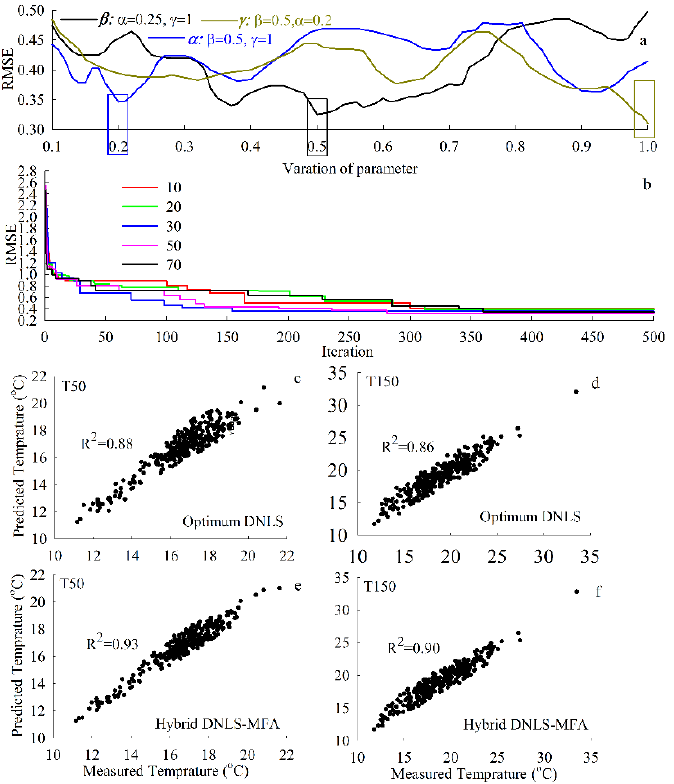
Figure 5. Adjusting the optimal values of MAF parameters ( a ), selected population of fireflies using convergence histories ( b ), and compared predictability of the optimum and hybrid DNLS model ( c – f ).